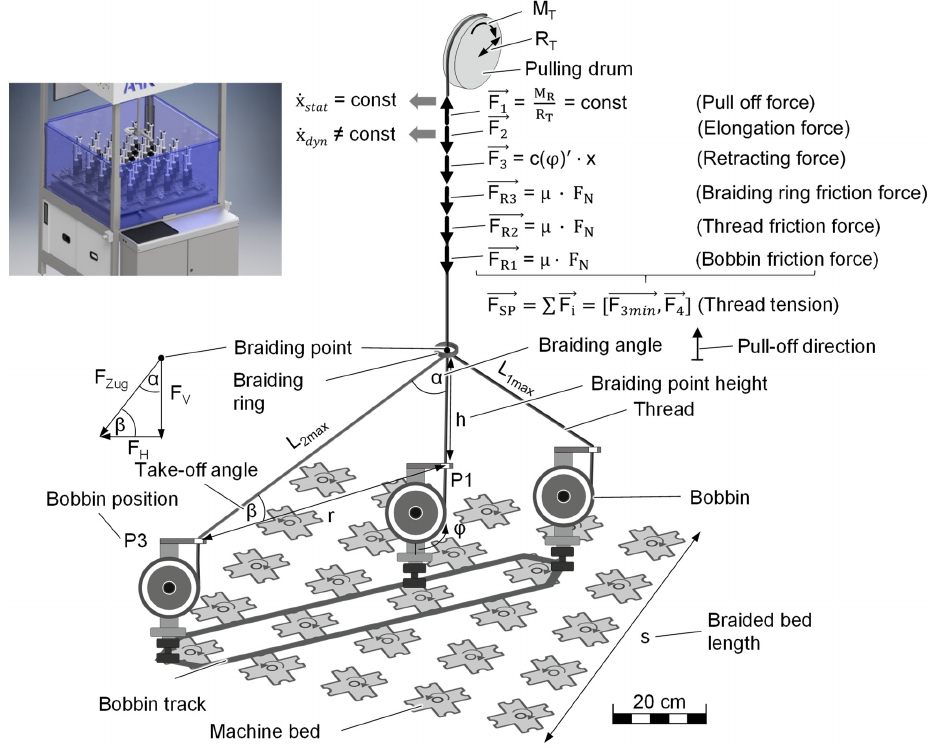
Figure 4. Kinematics and kinetics on the braided